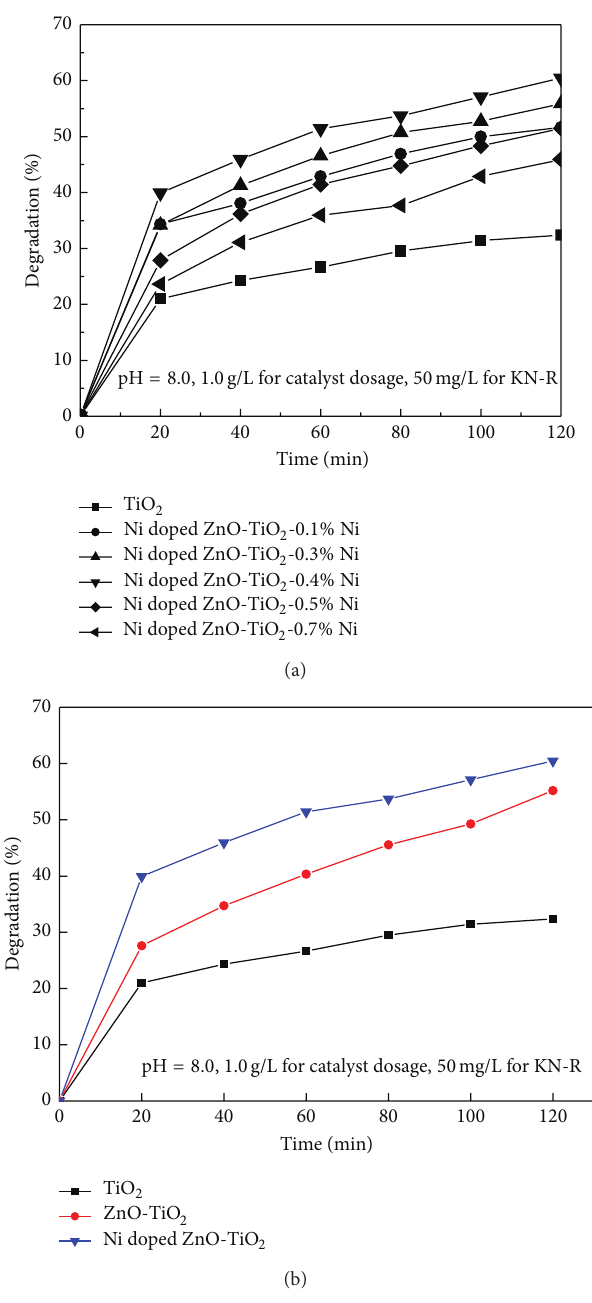
Figure 6: Plots of degradation of reactive brilliant blue KN-R over different samples under visible light